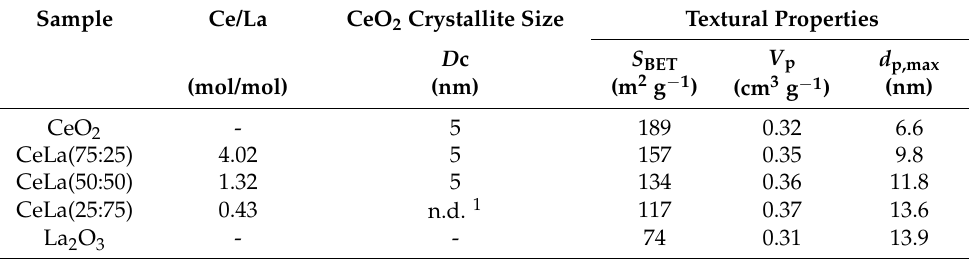
Table 1. Chemical composition, structural and textural properties of the prepared oxide catalysts.